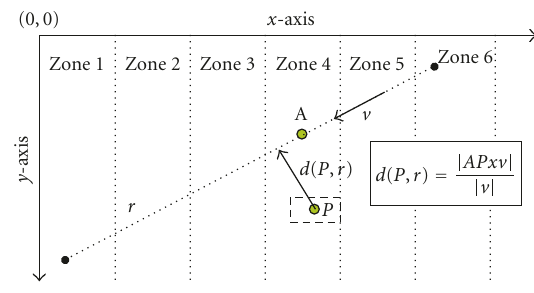
Figure 10: Distance from a target to a reference path.